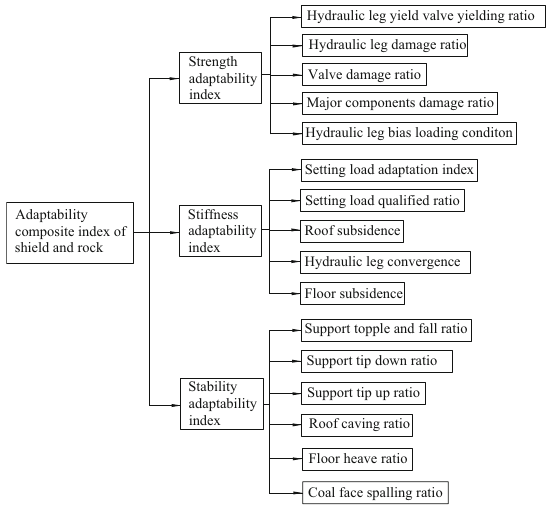
Fig. 3 Hydraulic support and surrounding rock adaptability evalua- tion